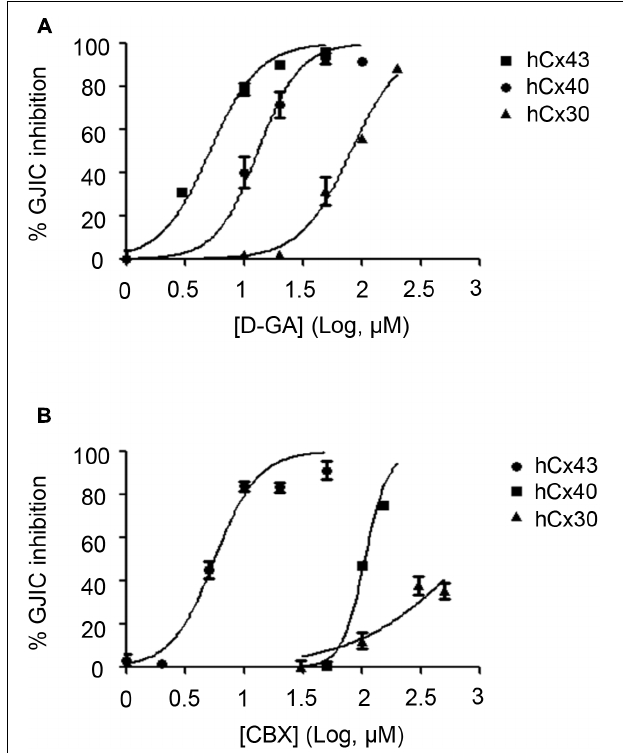
FIGURE 10 | IC50 values of D-GA and CBX inhibition of GJs composed of Cx43, Cx40, or Cx30. The 2:1 mixture of donor and acceptor cells originating from LN215-Cx43, -Cx40, or -Cx30 cells were plated, grown for 24 h, and then treated with various concentrations of D-GA (A) or CBX (B) for 10 min before the I-YFP assay. The percentage of GJIC inhibition was calculated and plotted against the log [compound] ( µ M). The data represent the mean ± SD ( n = 3). The IC50 values were calculated using GraphPad Prism